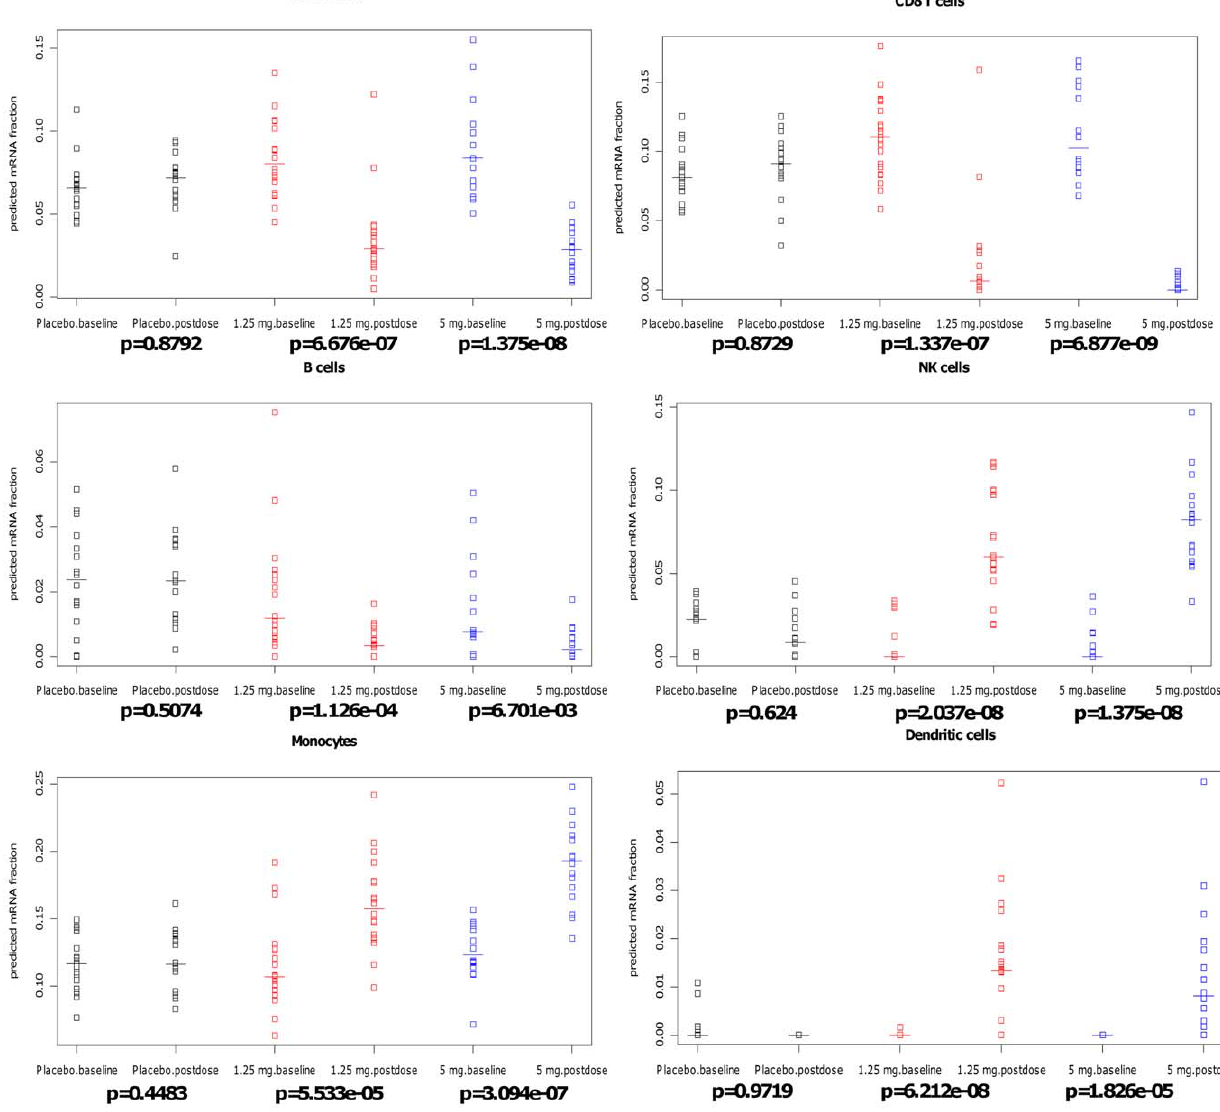
Figure 3. Estimated fractions for several circulating cell populations. Strip charts display relating quality of CD4 + cells/CD8 + /B cells/NK cells/ Monocytes/Dendritic cells. The data are stratified in three different subgroups: placebo (black), low dose: 1.25 mg/day (red) and high dose: 5 mg/day (blue). Data points are from each donor. Y axis is the estimated mRNA fraction. P-values are calculated by Wilcoxon’s Signed Rank test.